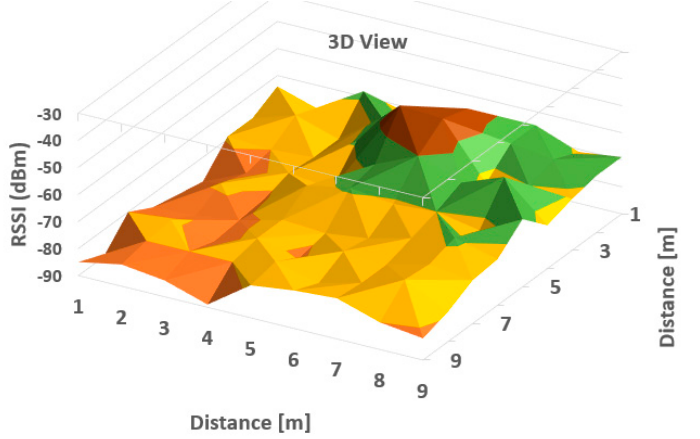
Figure 11. A three-dimensional representation of signal variation with different coloring according to RSSI measured values (Measurement point: MeS 3 ).